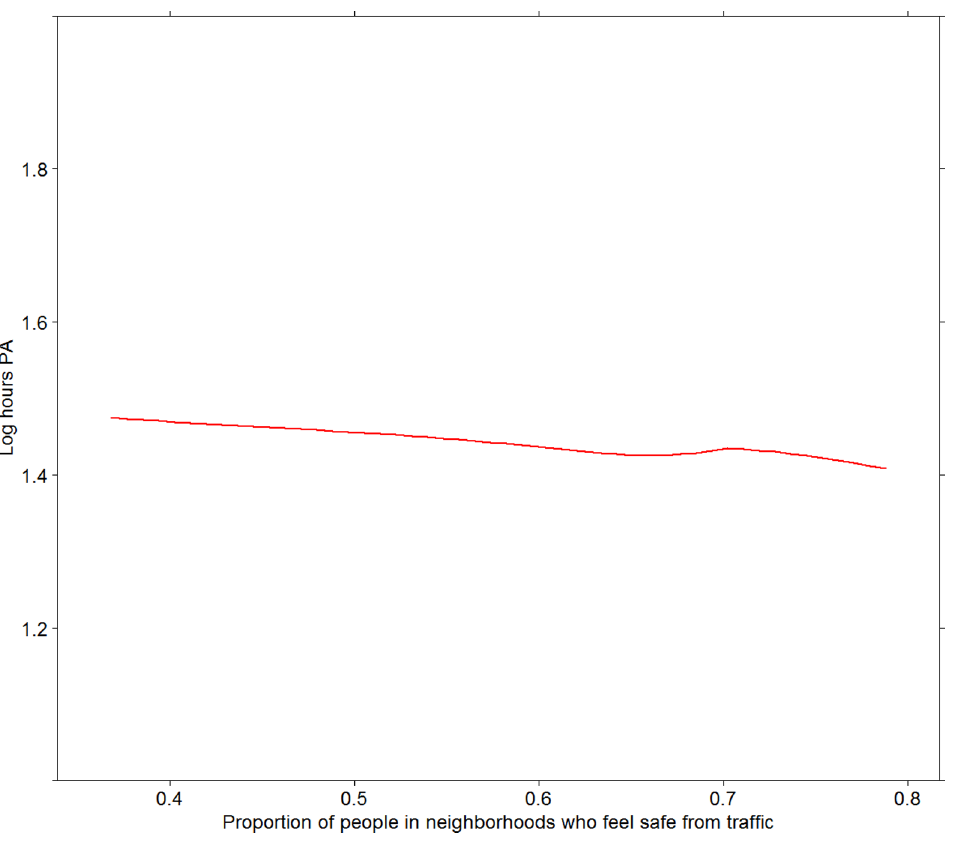
Figure 5. Frequency of PA in relation to levels of traffic safety in 2006. Frequency of PA is measured as log of hours of PA among those who are active. Relationship depicted by a Loess curve based on 1 degree of freedom.